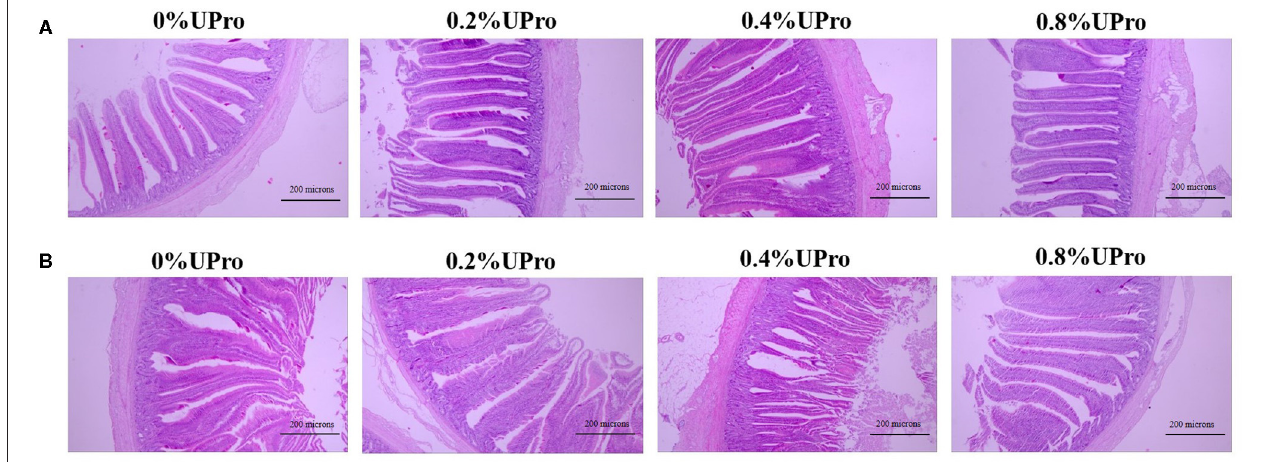
FIGURE 1 | Effects of dietary UPro on intestinal histomorphology of laying hens (40 × ). (A,B) The representative pictures of ileal and jejunum sections stained with hematoxylin and erosion (H&E),